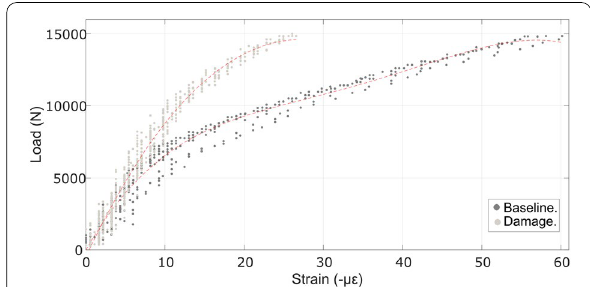
Fig. 13 Behavior of the FBG vs. load for undamaged and damaged